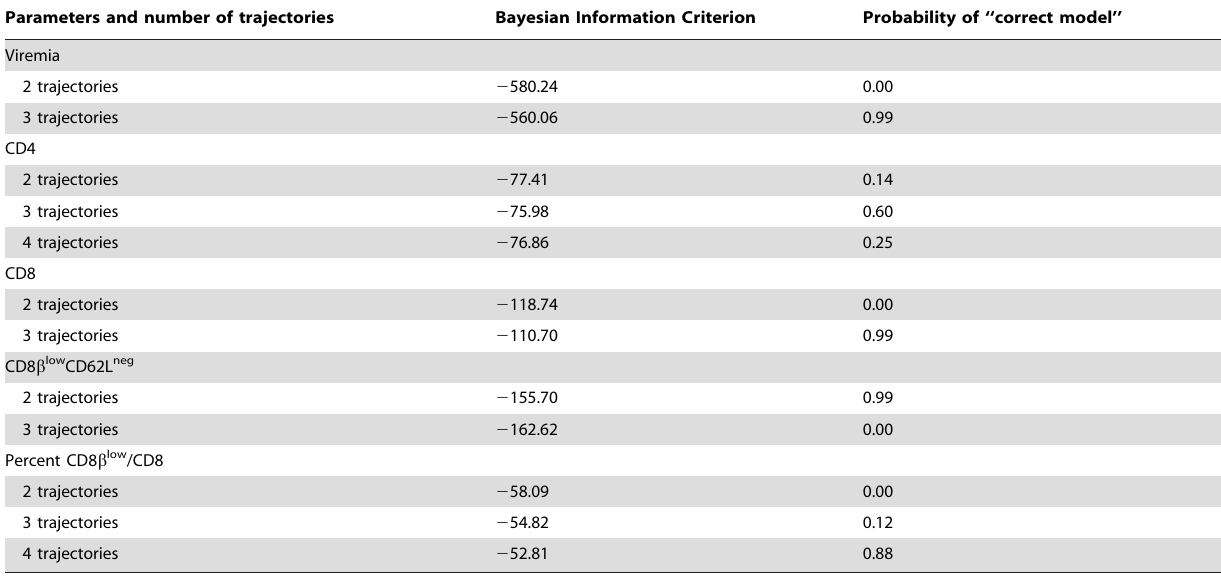
Parameters and number of trajectories